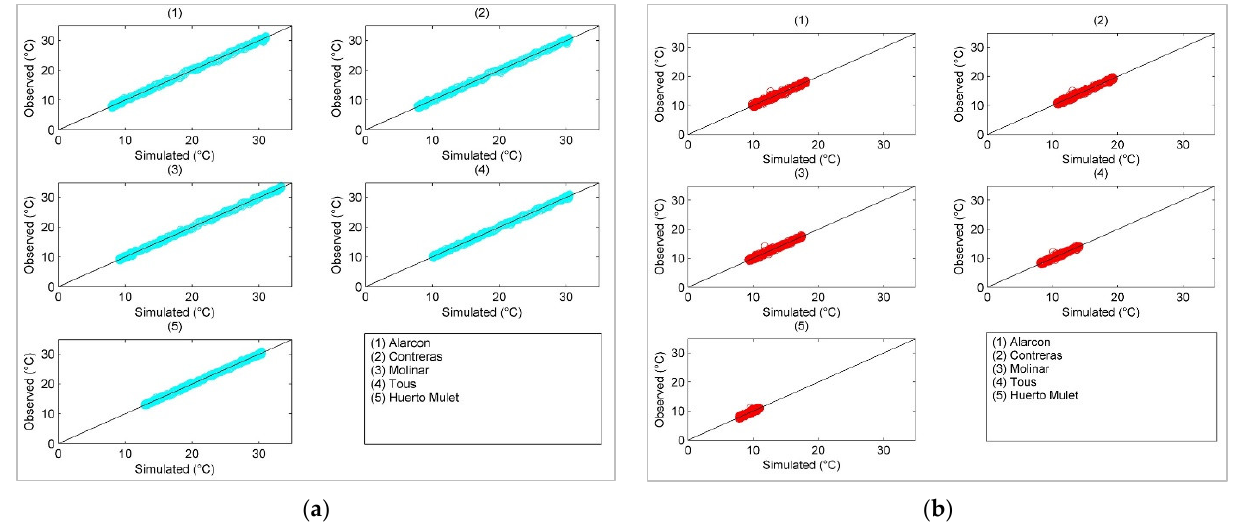
Figure 9. Scatter plots for observed mean versus generated temperature (mean 66 years observed and 1000 simulated series) for two models: ( a ) maximum temperature for each calendar day (blue) and ( b ) temperature range for each calendar day (red).